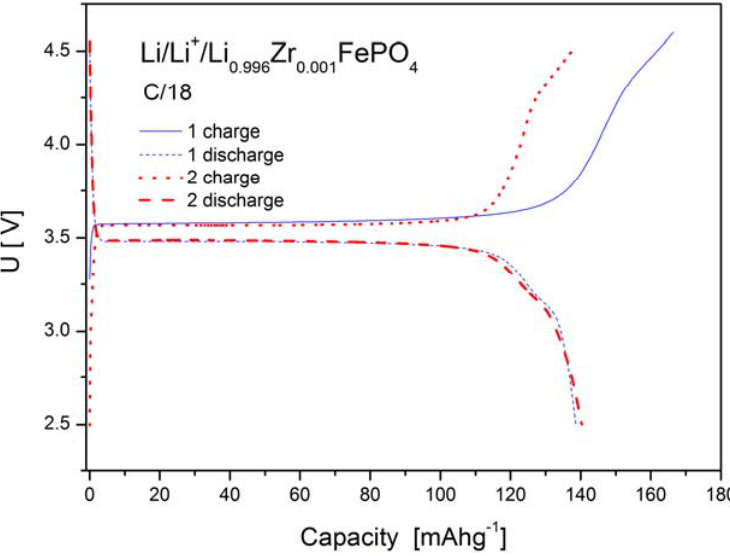
Zr FePO cell. 0.996 0.001 4